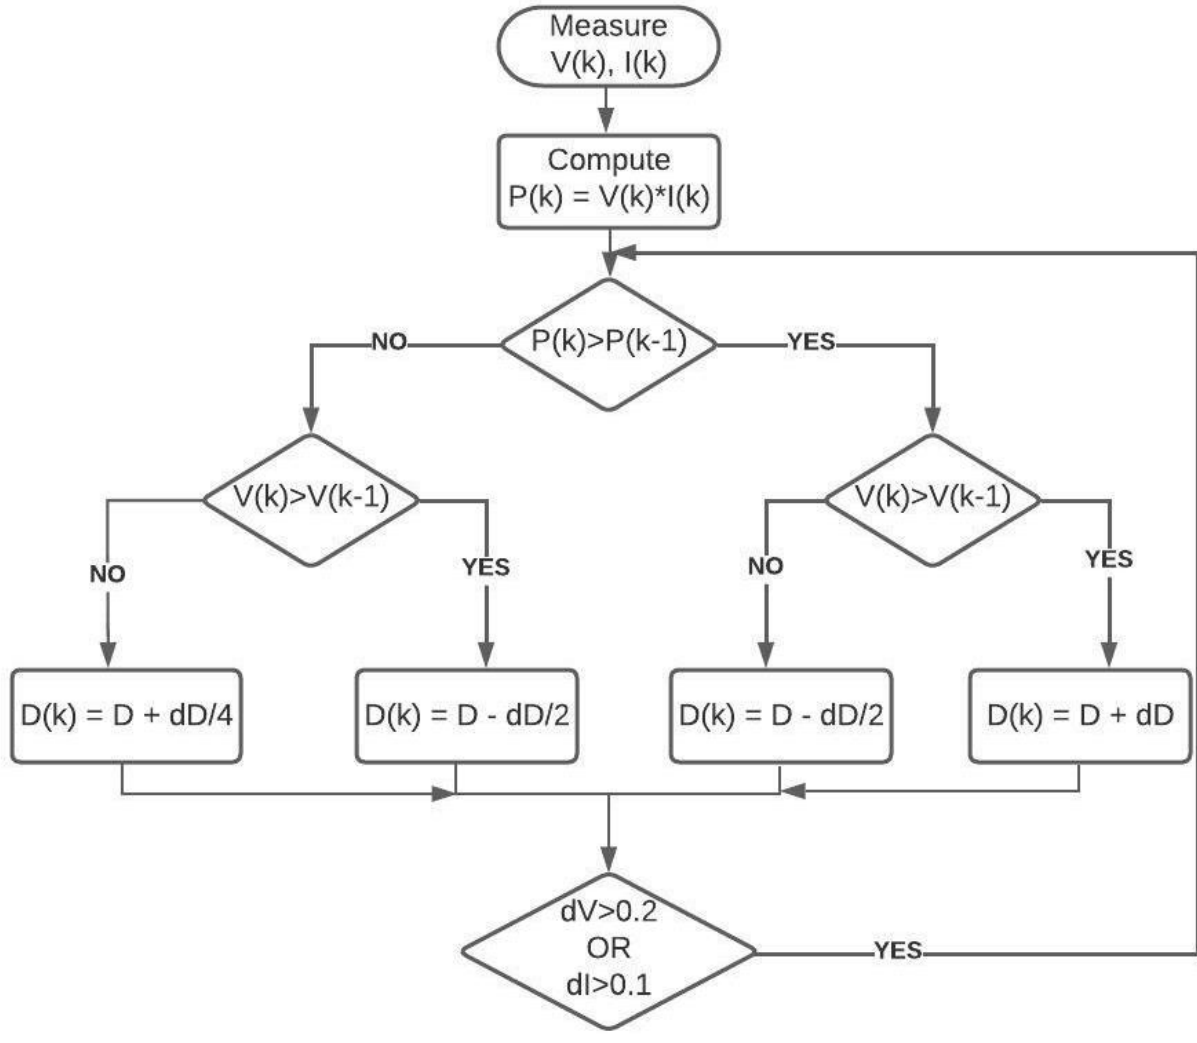
Fig. 3. Flowchart of the proposed optimized hill climbing algorithm